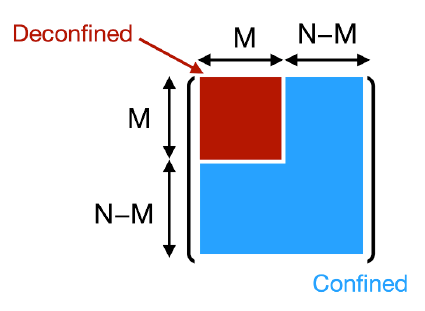
Figure 1. In the partially-deconfined phase (equivalently, partially-confined phase), color degrees of freedom split into the confined and deconfined sectors. In this paper, we use M to denote the size of the deconfined